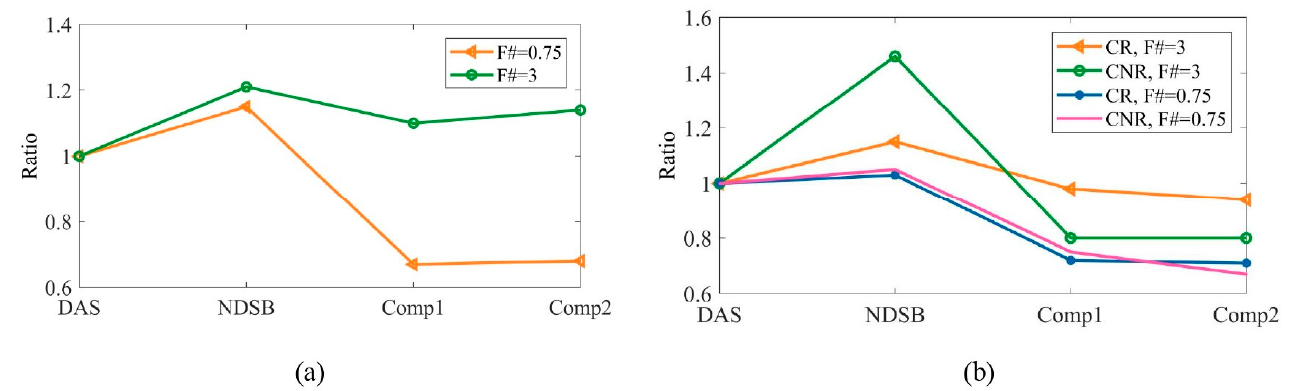
Figure 9. Comparison of transmit F# to ( a ) lateral resolution and ( b ) image contrast (CR, CNR).